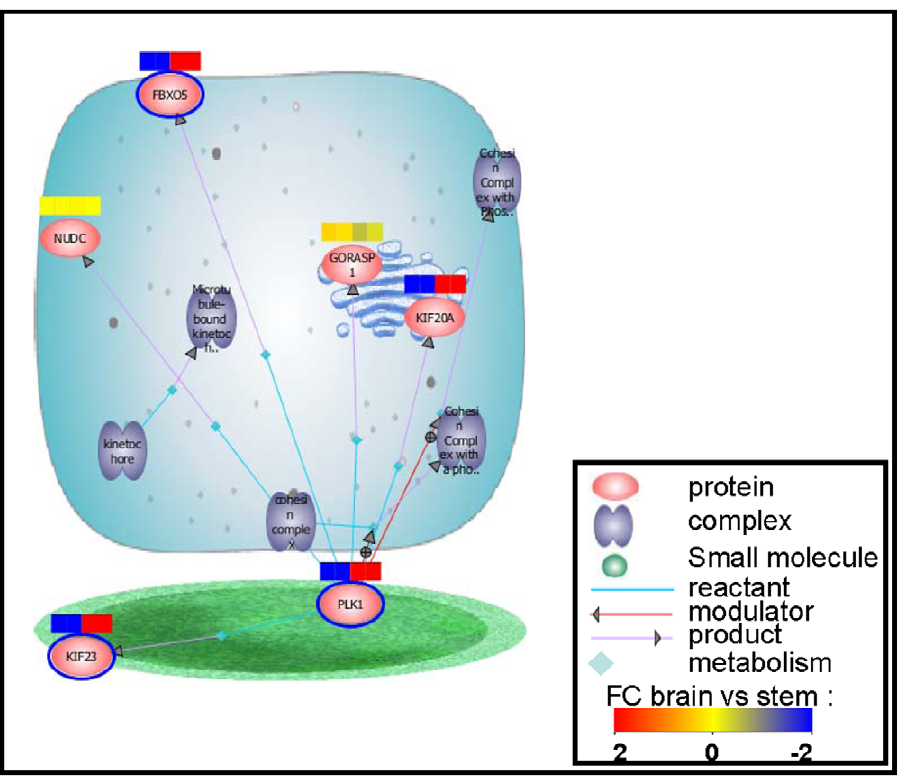
Figure 4. M phase Pathway. Ninety-one pathways were significantly found in the 1932 down-regulated mRNA set, among them we noted ‘‘M phase’’ The 1932 down-regulated mRNA set are significantly enriched by mRNA coding for proteins involved in ‘‘M phase’’ pathway.